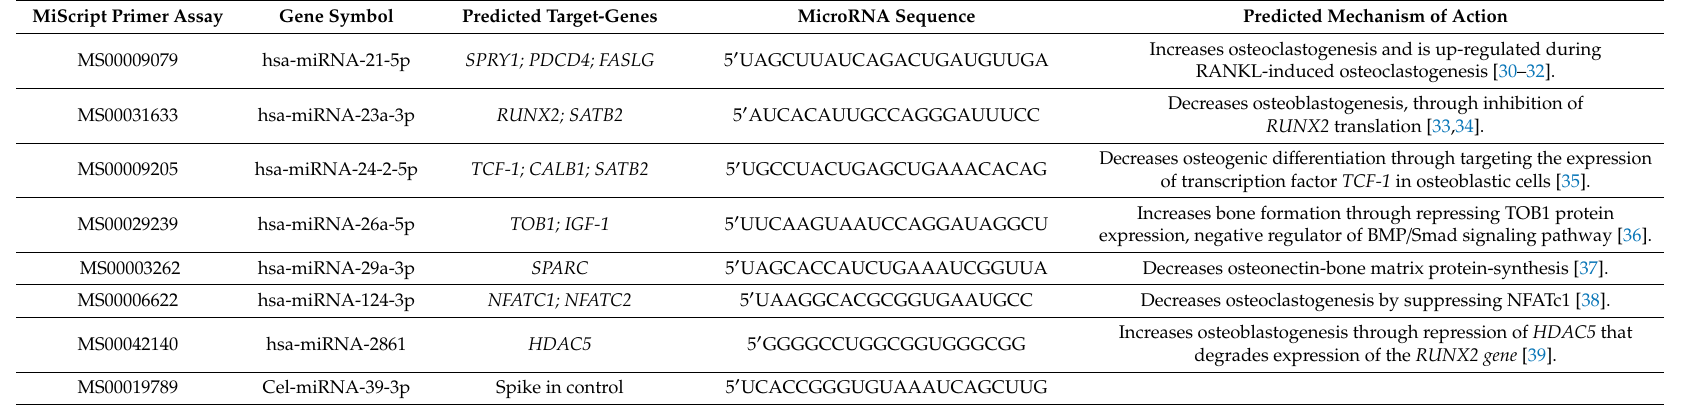
Table 1. Pre-specified panel of selected microRNAs linked to bone